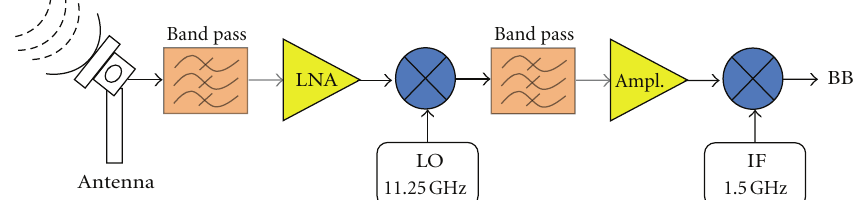
Figure 1: Typical satellite receiver block diagram.